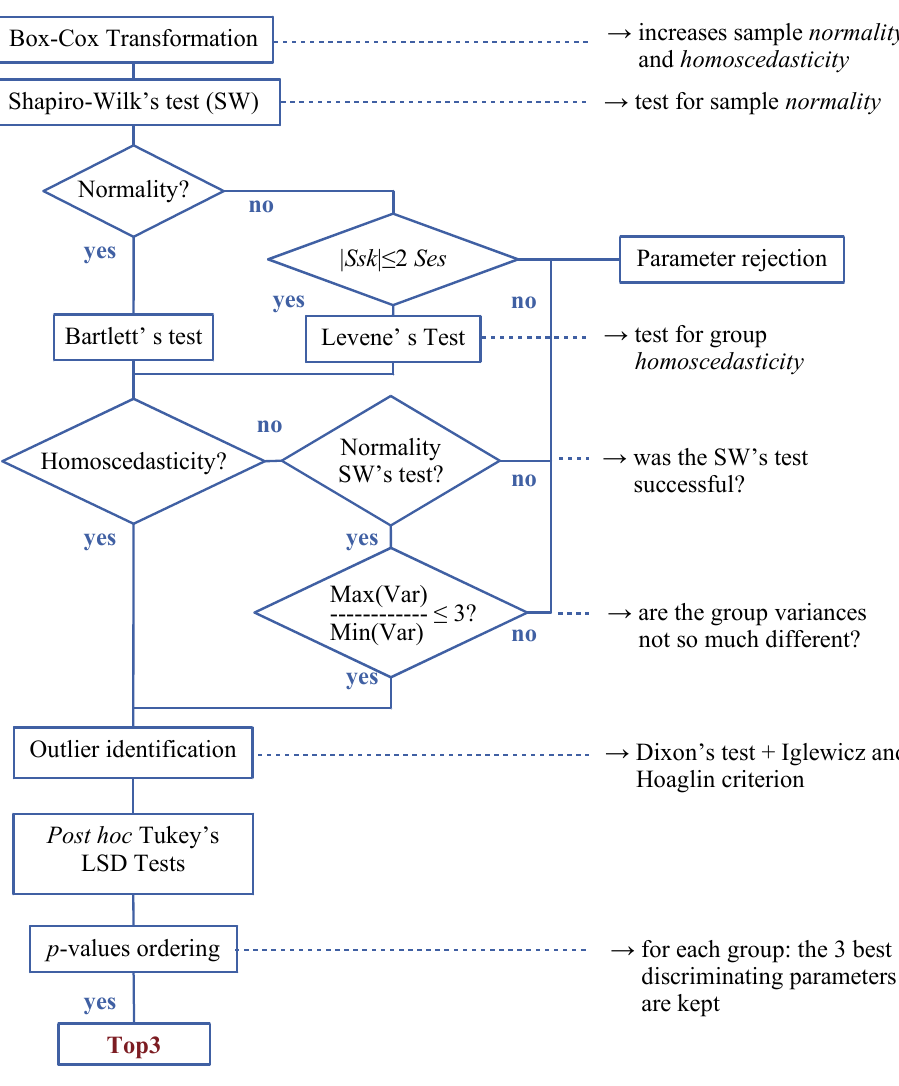
Figure 2. Synopsis of the procedure with all of the parameters as the input, and the three most discriminative ones as a result (Top3).